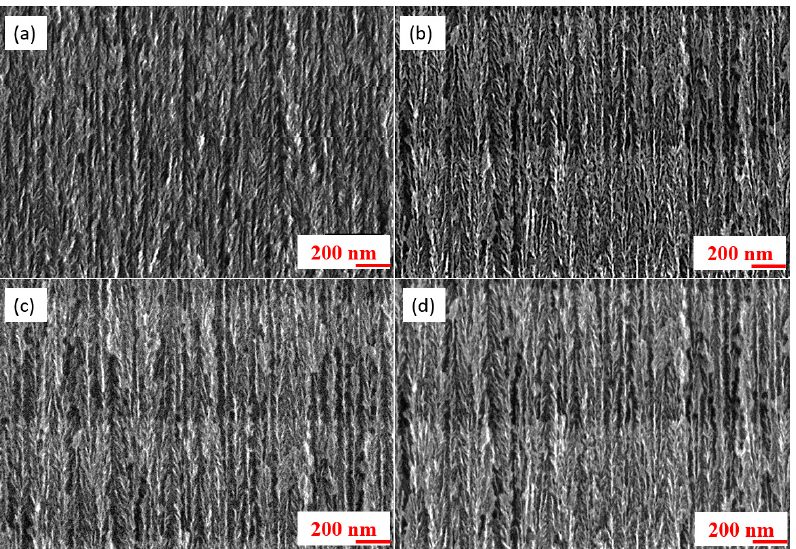
Nanomaterials 2023 , 13 , x FOR PEER REVIEW